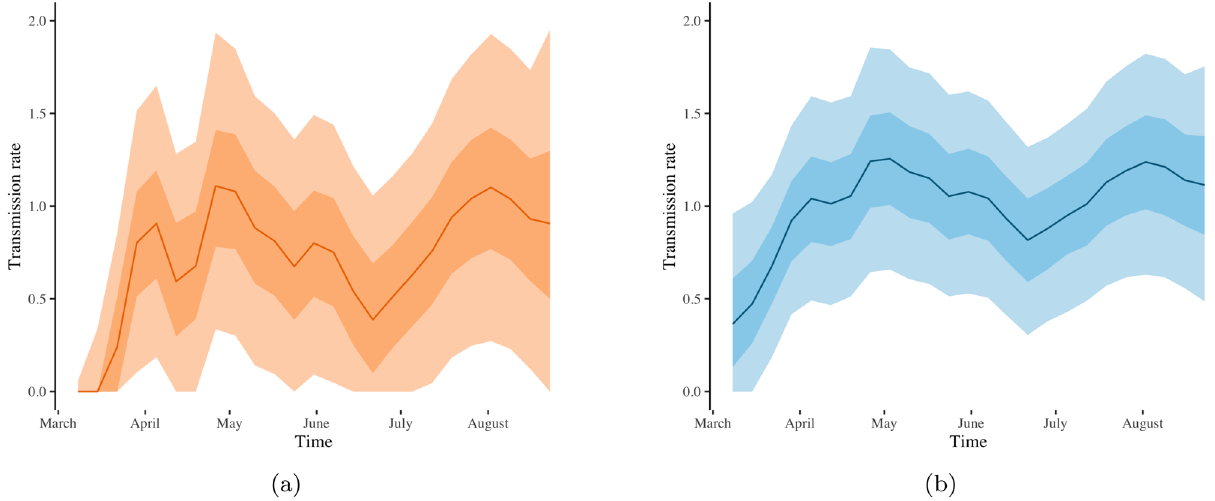
Figure 7. Estimates of the COVID-19 transmission rate for Tennessee based on the typical SEIR model with constant reporting rate ( a ) and based on our SEIR model with a time-varying reporting rate p t ( b ). Solid lines, light-shaded and dark-shaded areas correspond to posterior means, 75% and 95% credible intervals of the associated transmission rates.